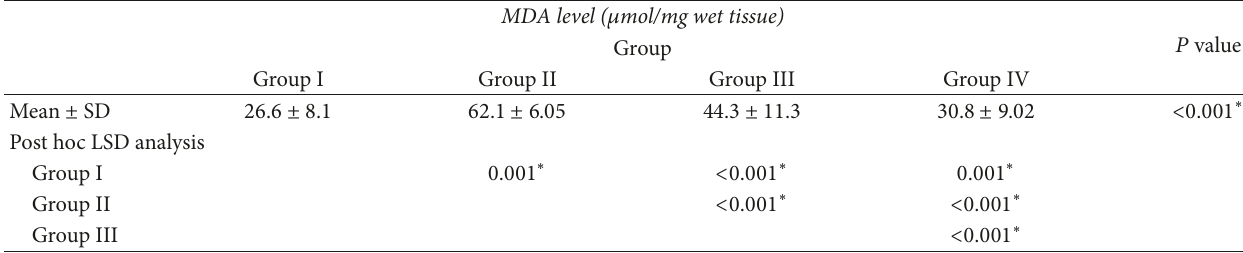
Table 5: One-way ANOVA statistical analysis of MDA level in adrenal glands in different experimental groups (𝑛 = 10)